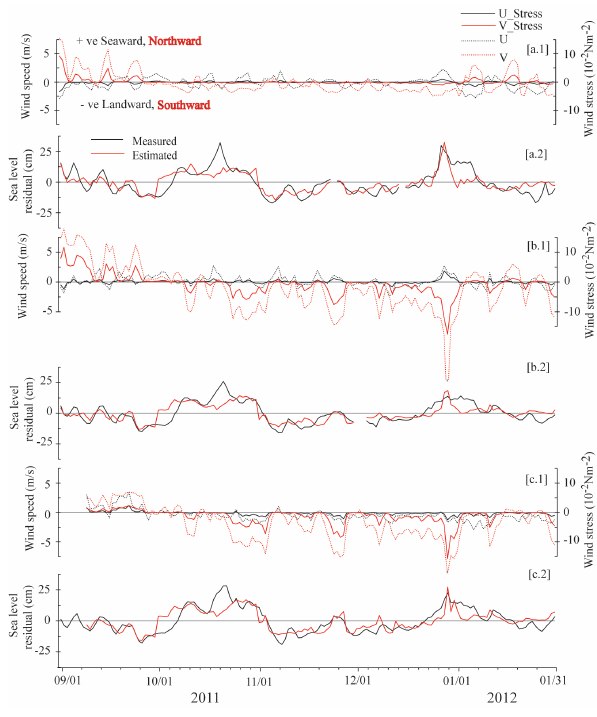
Figure 7. Daily mean wind, wind stress, measured sea level resid- ual and estimated sea level residual from September 2011 to Jan- uary 2012 at (a) Gopalpur, (a.1) daily averaged cross-shore (black) and along-shore (red) winds stress along with respective winds (dot- ted black or red), (a.2) daily mean measured sea level residual (black) and estimated residual (red); (b) Gangavaram, (b.1) and (b.2) same as in (a) ; (c) Kakinada, (c.1) and (c.2) same as in (a) . Daily mean estimated SLR is obtained using the multi-linear re- gression method using daily mean cross-shore ( τ U ) , along-shore ( τ V ) components of winds stress and atmospheric pressure ( A P ) as independent